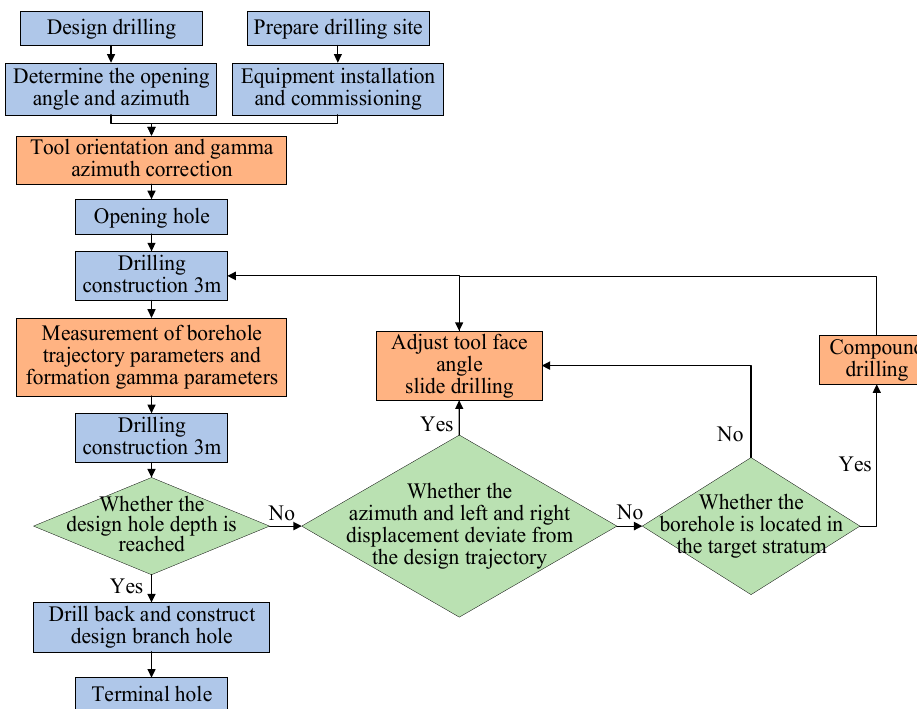
Figure 17. Flow chart of geosteering drilling.